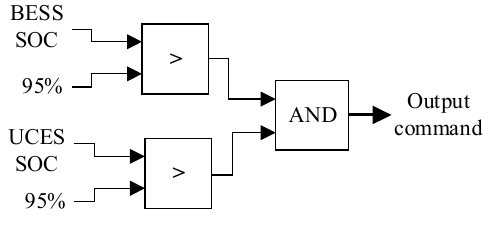
Figure 10. Braking chopper control strategy.